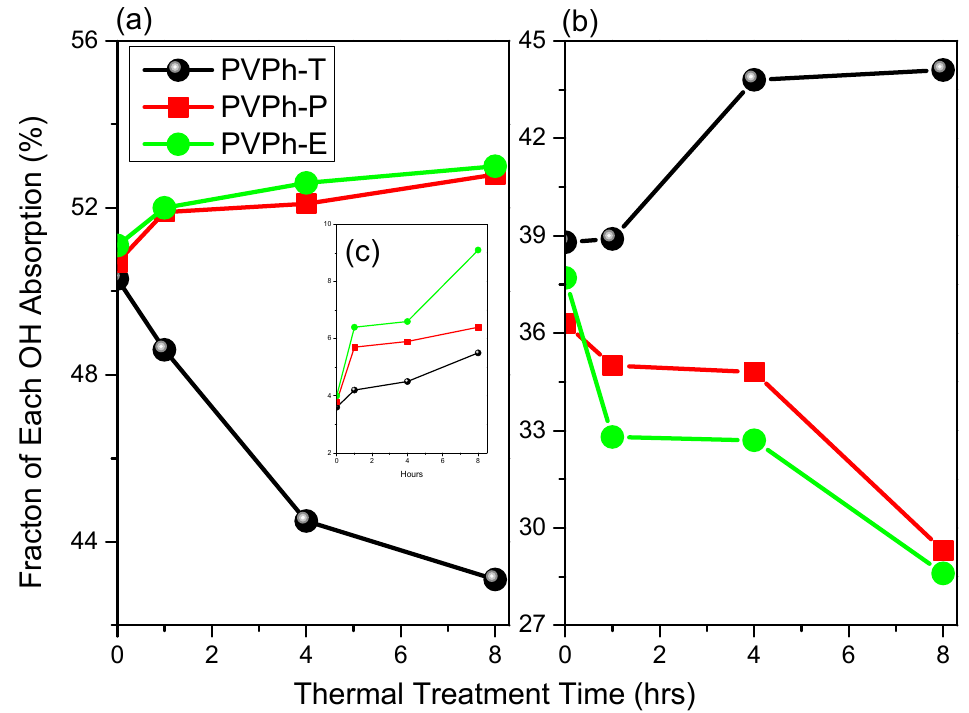
Figure 4. Fractions of ( a ) intermolecular hydrogen bonds, ( b ) intramolecular hydrogen bonding, and ( c ) free OH in PVPh-T, PVPh-P, and PVPh-E thermally treated for different times.